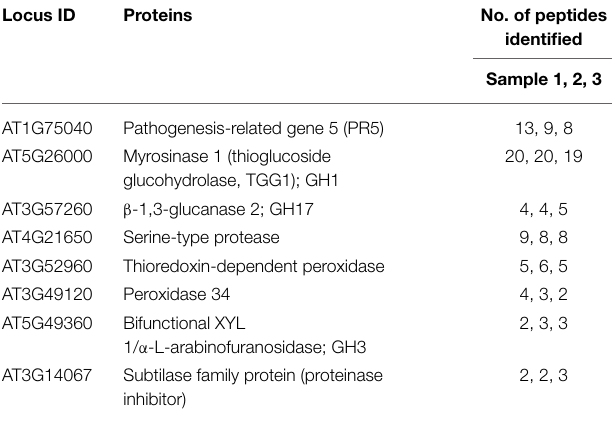
TABLE 1 | List of 8 identified ionically bound cell wall proteins in Arabidopsis stems at late growth stage, using the in-solution method coupled with